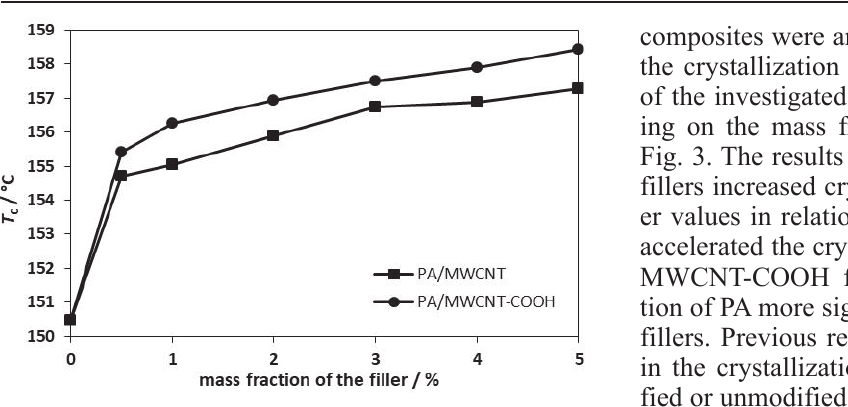
Fig. 3 – Crystallization temperature of PA/MWCNT and PA/ MWCNT-COOH nanocomposites